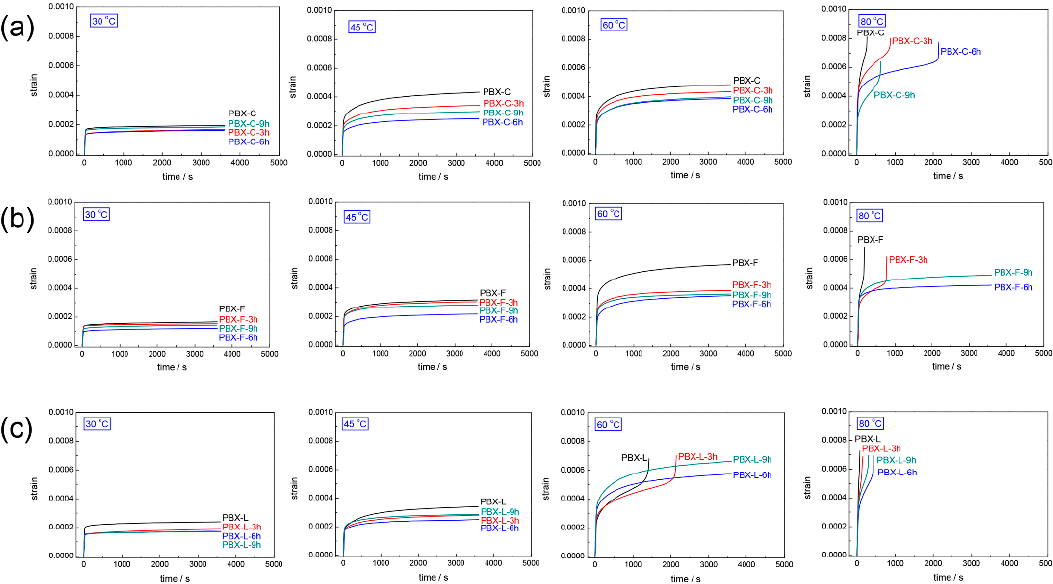
Figure 5. Time-dependent creep strain of PBXs at different temperatures under 4 MPa: ( a ) PDA modified PBX-C, ( b ) PDA modified PBX-F, ( c ) PDA modified PBX-L.